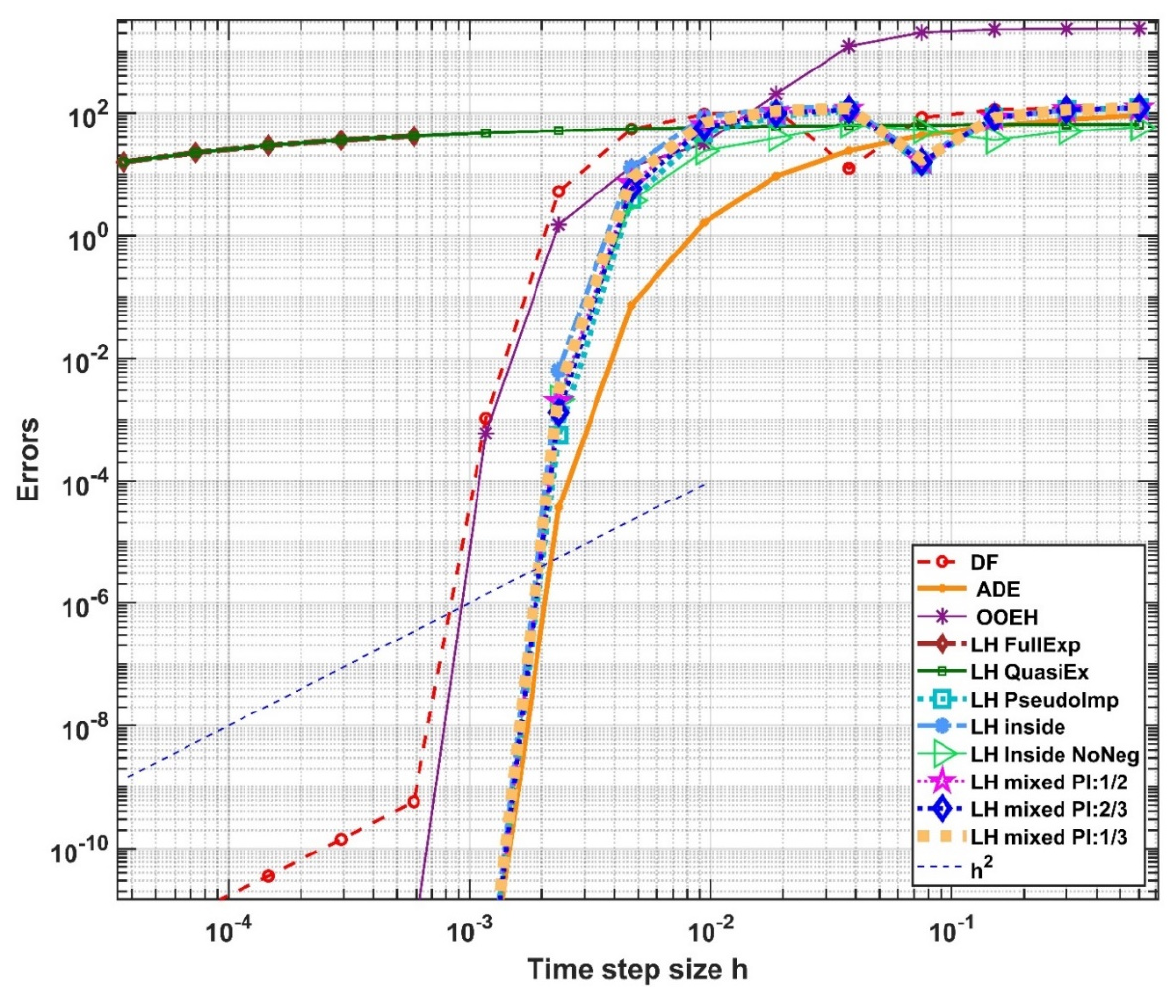
Figure 4. The L ∞ errors as a function of the time step size h for large K (Experiment 2).